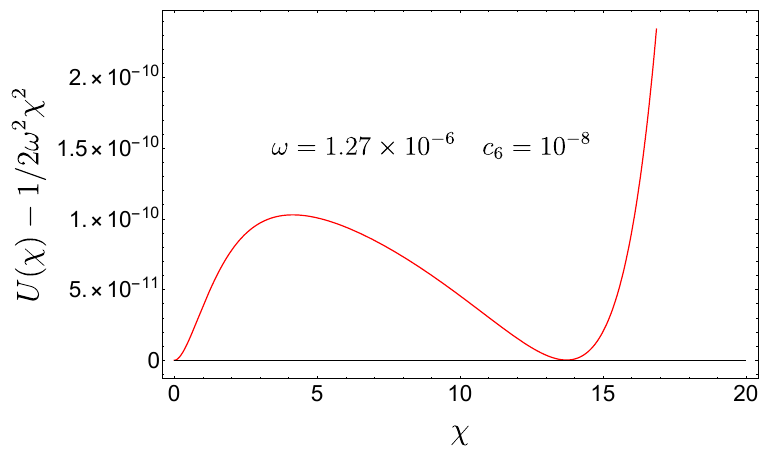
Figure 6 . An example of the effective potential for bounce solutions in our framework, with all of the parameters given in Planck